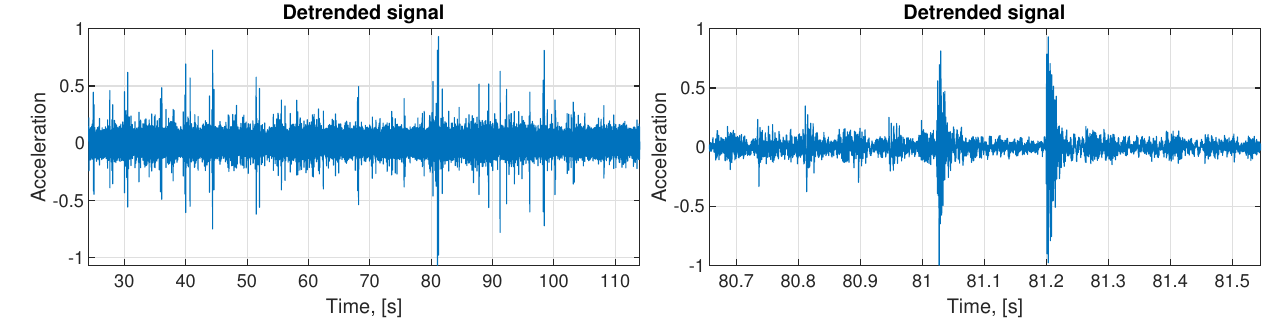
Figure 10. The signal after the main sine subtraction ( left ) and its short part for better visibility ( right ).